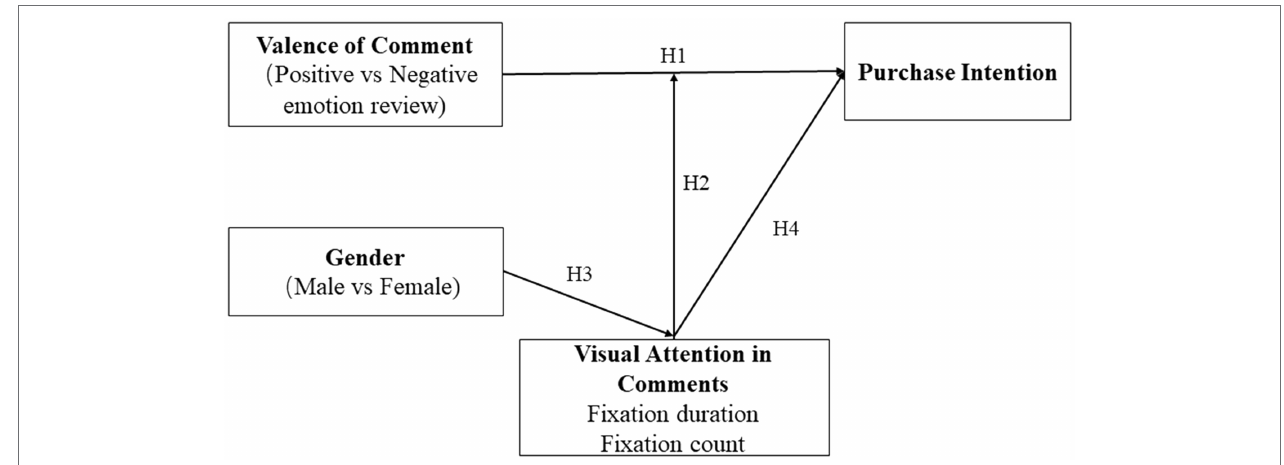
FIGURE 1 | Conceptual framework of the